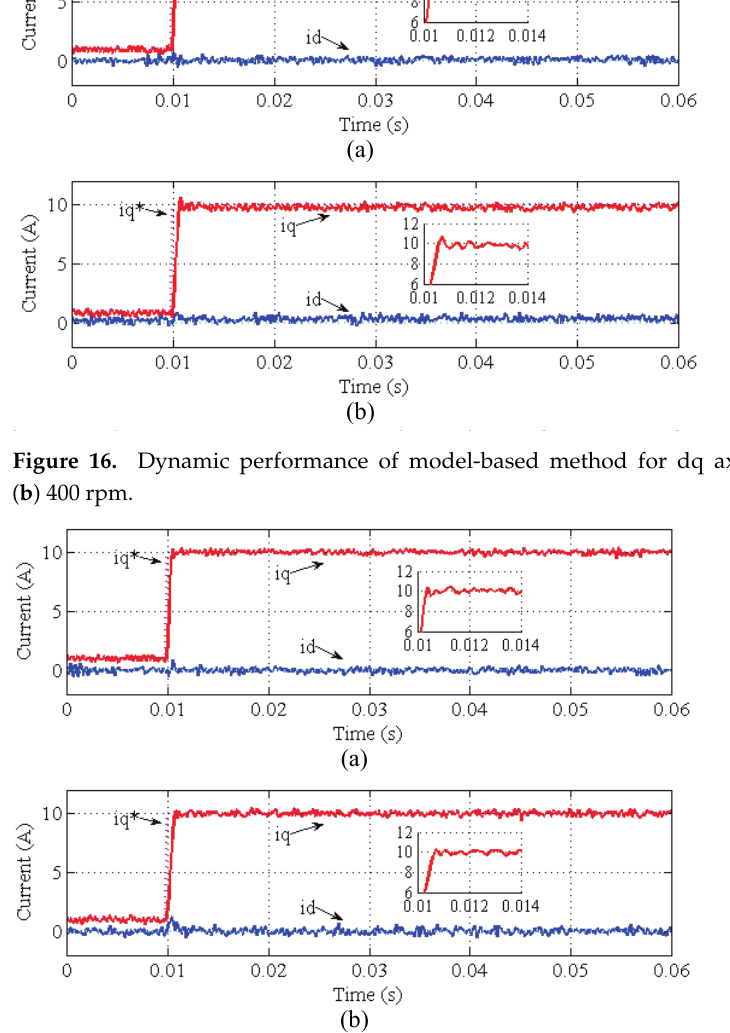
Figure 17. Dynamic performance of model-free method for dq axis currents: ( a ) 100 rpm; ( b ) 400 rpm. Fig. 15. dq -Axes stator current dynamic performance of the proposed method: (a) At 100rpm; (b) At 400rpm. To improve the steady-state performance of synchronous motors (PMSMs), a model- free predictive control (MFPC) [26] has been proposed. As a model-free approach, an ultra- local model is derived using parametric system identification. Moreover, to reduce the switching frequency, a second term is added in the cost function. The proposed approach shows better results compared to the FCS-MPC and FS-MMFPC methods, and the